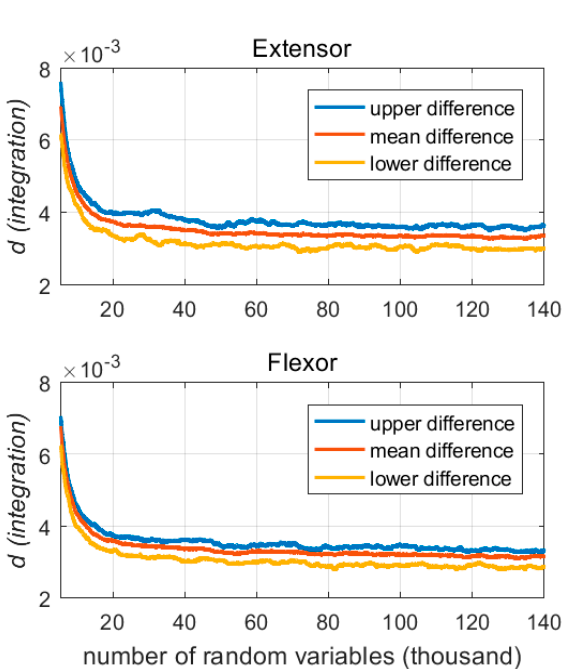
Figure 4. The results of the convergence experiment for determining the number of random variables.